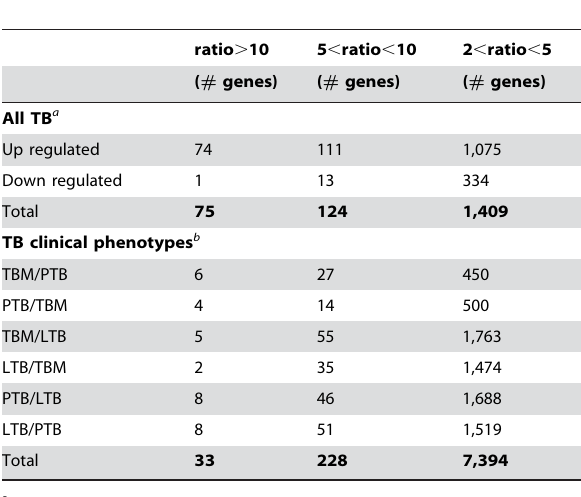
Table 1. Gene expression ratios in Mtb stimulated